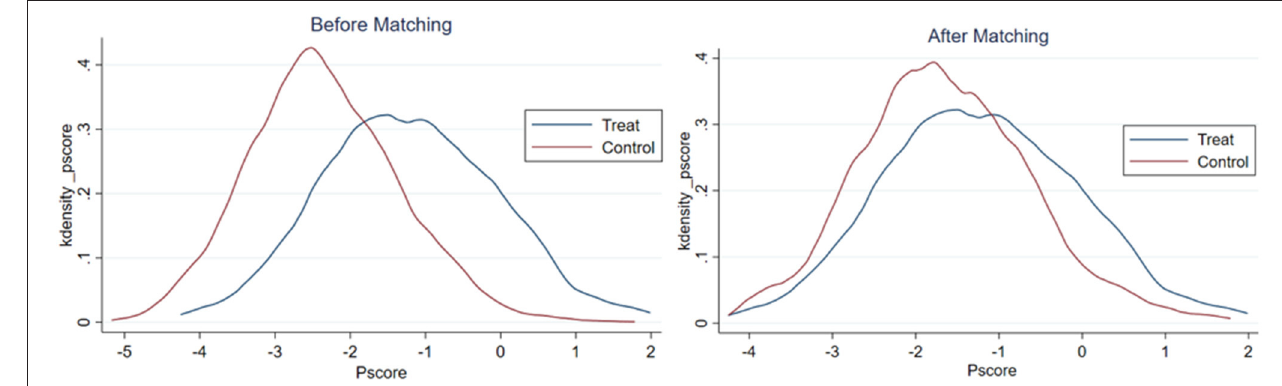
FIGURE 2 | Results of balance hypothesis test: employed.